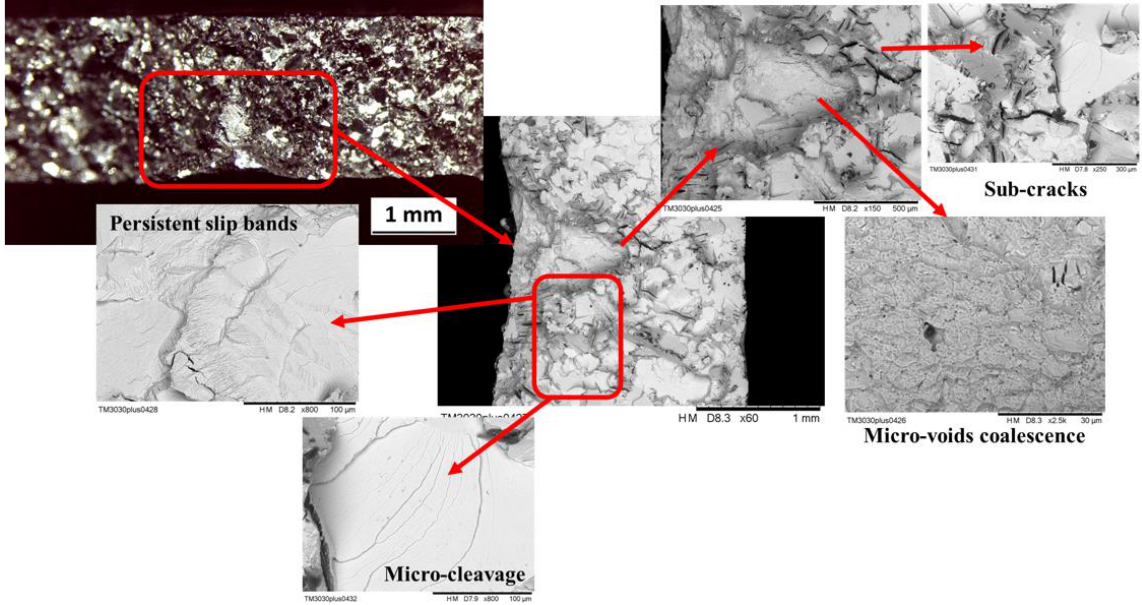
Figure 16. Fracture surface of the specimen tested at ∆ σ = 170 MPa and failed at 1,148,109 cycles (specimen 3).